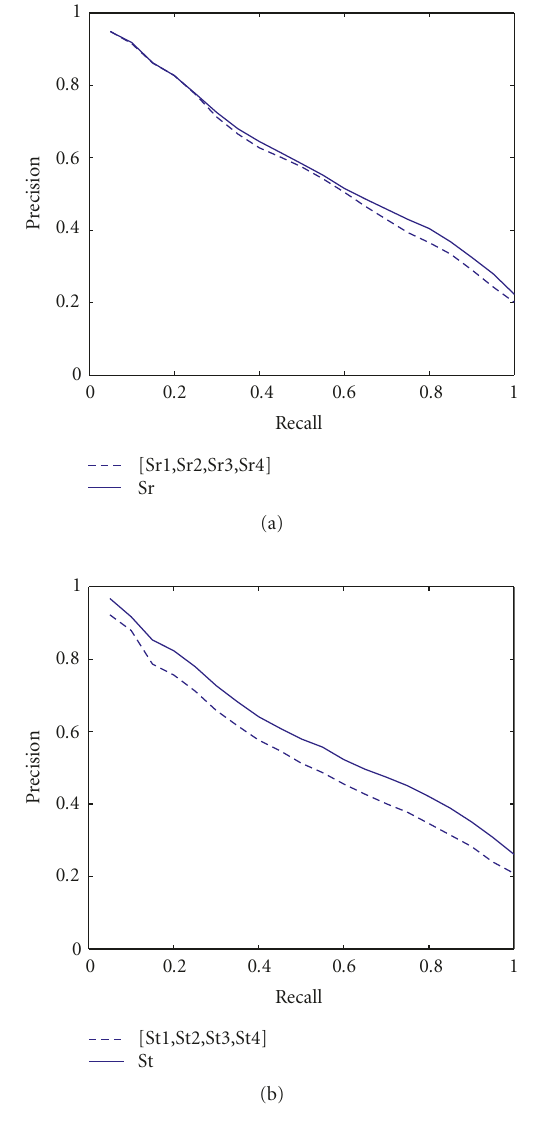
Figure 7: Precision-recall curves for [Sr1,Sr2,Sr3,Sr4] versus Sr (a) and [St1,St2,St3,St4] versus St on SCUdb (b).